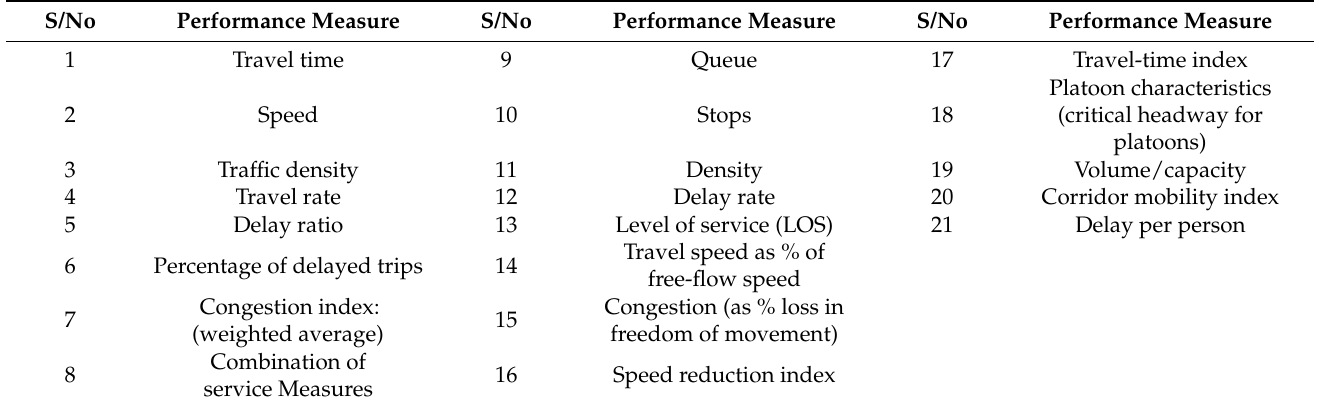
Table 1. Mobility Performance Measures Identified from Past